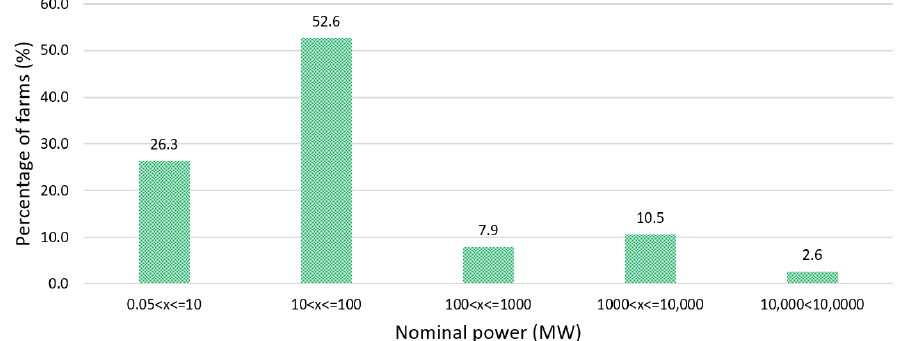
Figure 5. Ranges of rated powers of wind farms.